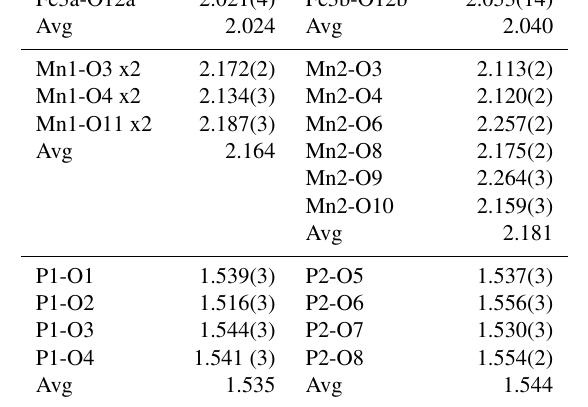
The close match of the a and b parameters for allanprin- gite to the b and c parameters for strunzite is the basis for the epitaxial growth of allanpringite on strunzite. The pairs of unit-cell parameters differ by only 0.7 %. The (001) planes in allanpringite and (100) planes in strunzite contain iden- tical structural motifs, comprising 7.3 Å chains of corner- connected octahedra that are interconnected along the 9.8 Å axis by corner linking to PO 4 tetrahedra, as illustrated in Fig. 9. Relief of the strain associated with the small mismatch between the unit-cell parameters of the two structures may be the cause of the transverse cracks in the central strunzite needle shown in Fig.